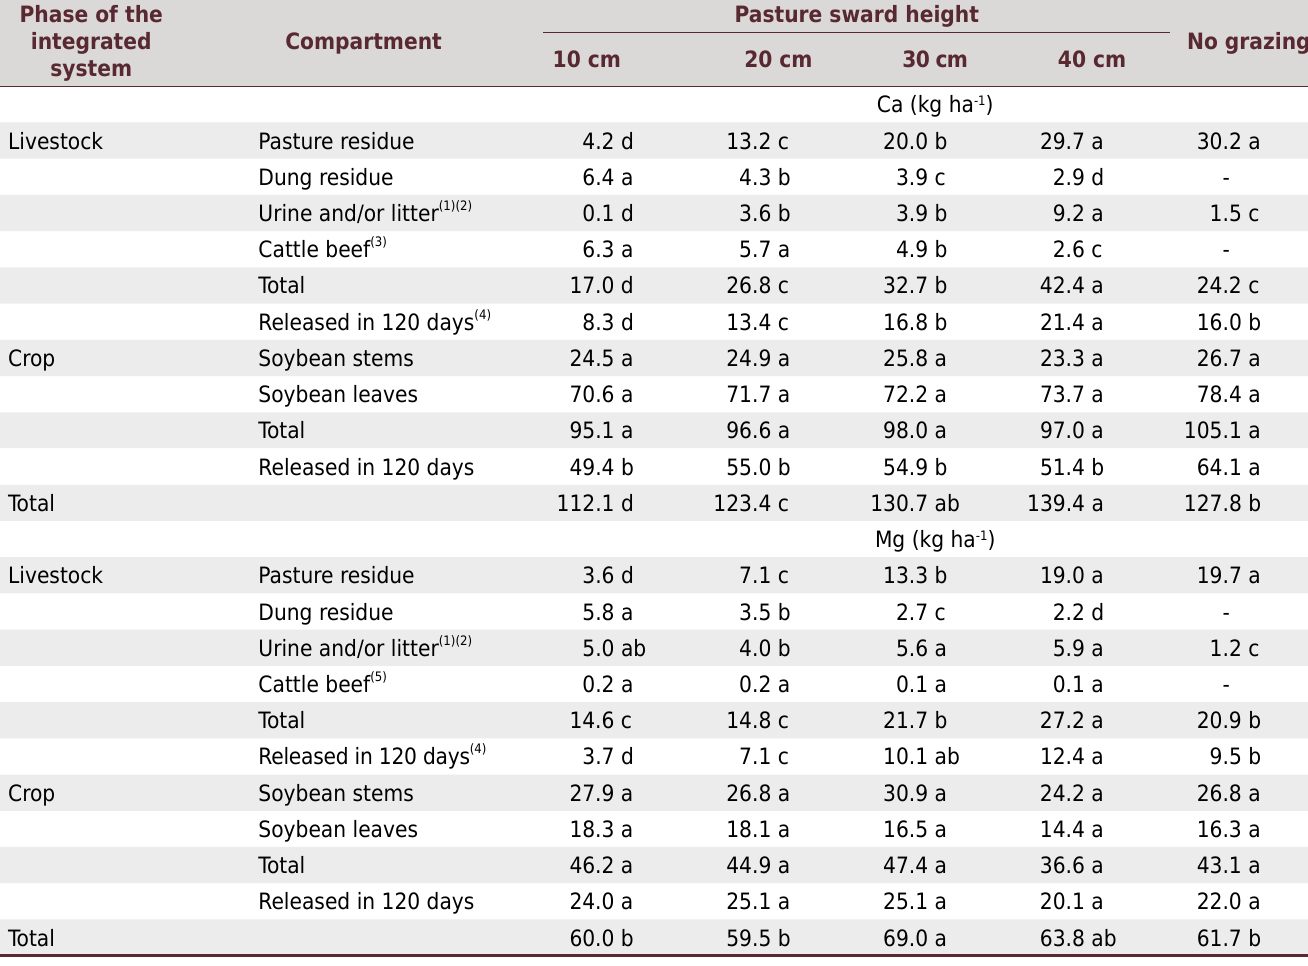
Table 2. Total amounts of calcium and magnesium and amounts in compartments to be cycled, and fraction released in 120 days in an integrated soybean-beef cattle system under no-till at different grazing intensities (i.e., sward height managed by grazing) (São Miguel das Missões, RS, Brazil) Pasture sward height No grazing 10 cm